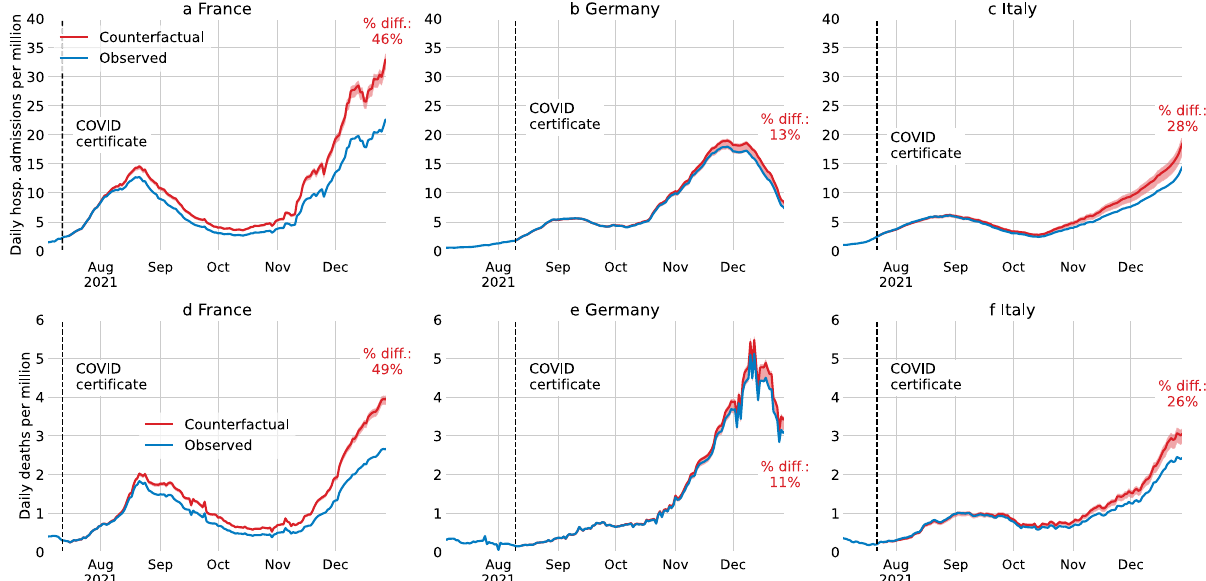
Fig. 2 Estimated hospital admissions and deaths with and without COVID certi fi cates. For France ( a and d ), Germany ( b and e ), and Italy ( c and f ), daily hospital admissions (top row) and deaths (bottom row) per million (7-day rolling average) in the actual intervention deployment (blue) and in the no- intervention counterfactual scenario (red). The red shaded area is the 95% con fi dence interval centred around the main estimate. The daily death counterfactuals for France and Italy, and the daily hospital admissions counterfactual for France are computed using an age-strati fi ed model. The other counterfactuals are not based on age-strati fi ed models due to unavailable data. The black dashed vertical line is the date of the announcement of the COVID certi fi